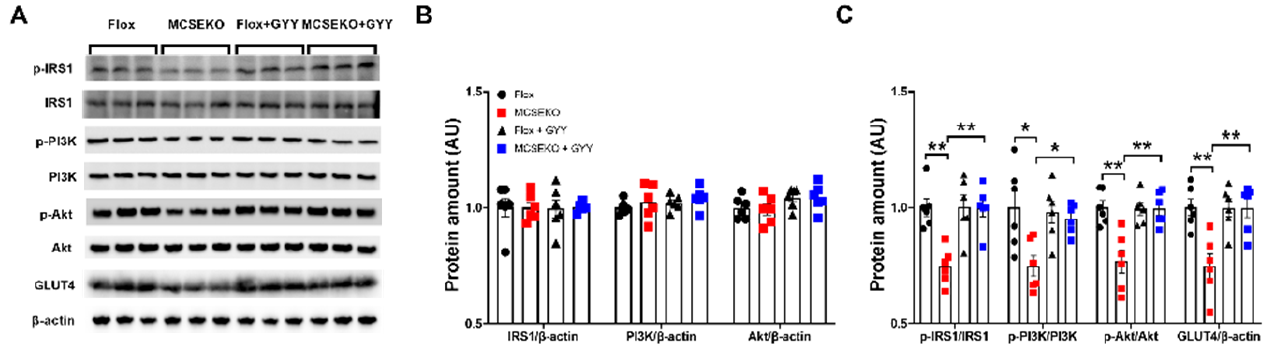
Figure 5. The skeletal muscle levels of IRS/PI3K/Akt signaling and GLUT4 are down-regulated in MCSEKO mice and GYY4137 treatment can increase them. MCSEKO mice and Flox mice were treated with GYY4137 or vehicle for six weeks. Western blot analysis of p-IRS1, IRS1, p-PI3K, PI3K, p-Akt, Akt, and GLUT4 protein levels in GAS muscle. ( A ) The representative images of western blotting. ( B , C ) Cumulative data of western blotting images. Data were expressed as means ± SEM ( n = 6 in each group). * p < 0.05, ** p < 0.01.